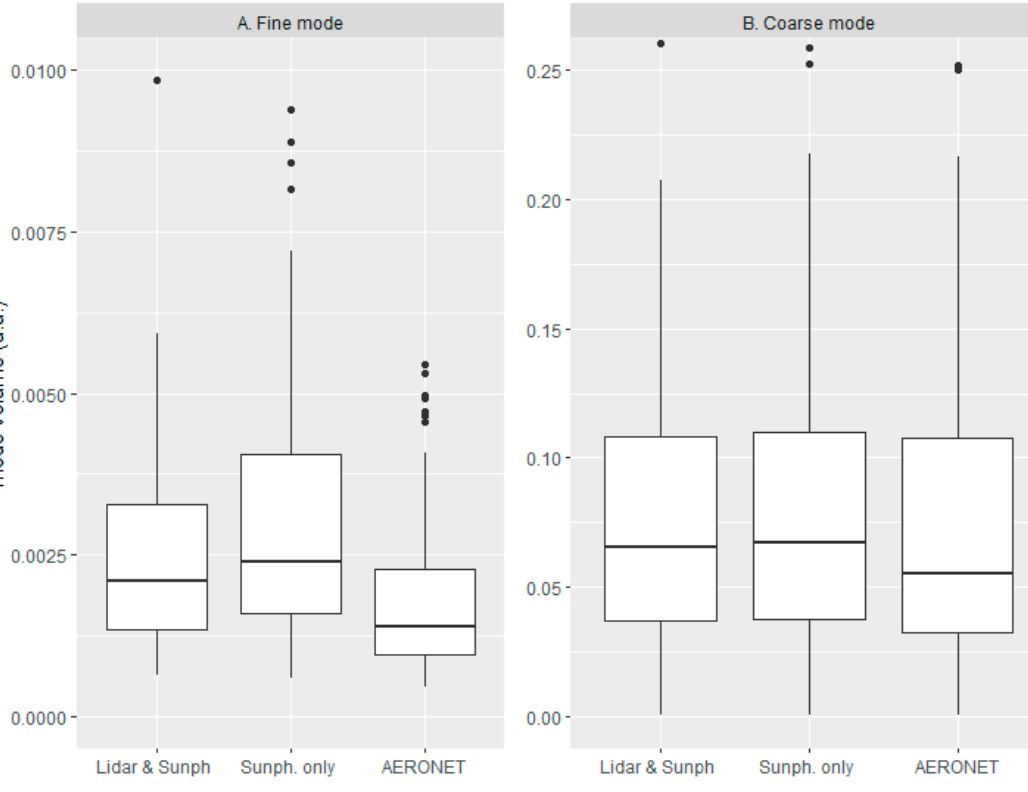
Figure 6. Boxplots of the volume for ( A ) fine and ( B ) coarse modes for the two di ff erent GRASP schemes (Scheme 1, labeled as Sunph. only. Scheme 2, labeled as Lidar & Sunph.) and AERONET.